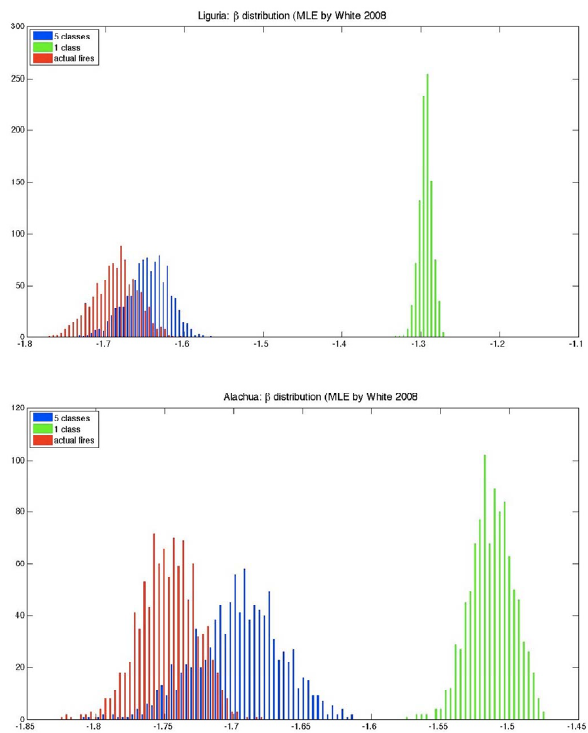
Fig. 2. Distribution of parameter β respectively simulated by MFFM (blue), DS-FFM (green) and actual fires (red). The results obtained for the Liguria and Alachua case studies are reported above and below, respectively.